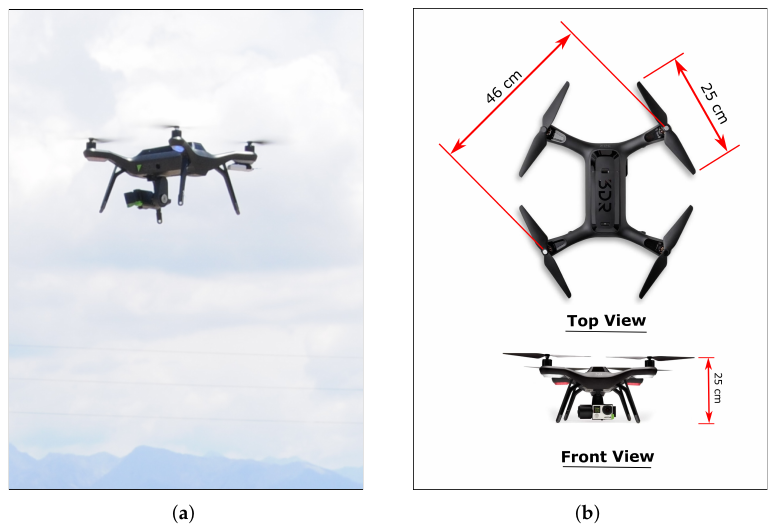
Figure 3. ( a ) The multirotor UAS employed for validation of model-based wind estimation along with ( b )